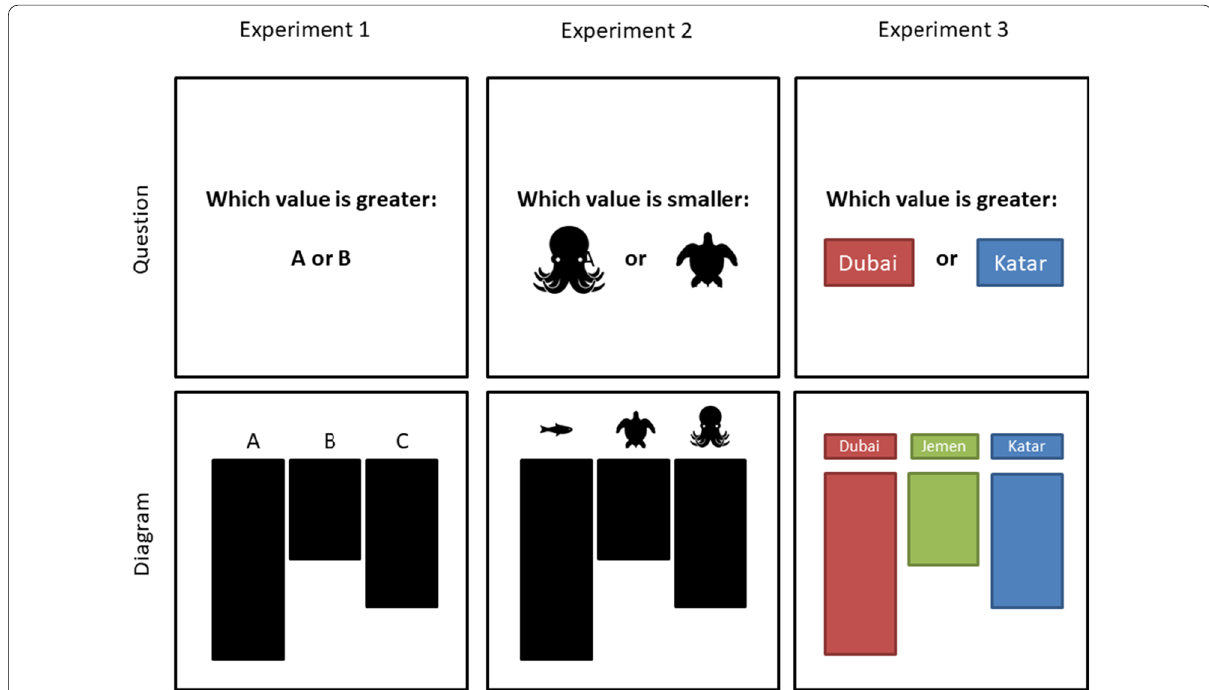
Fig. 3 Schematic depiction of the stimuli for the reported experiments. Experiment 1 used letter and word labels. Experiment 2 employed word and pictograph labels. In Experiment 3, the coloring of the bars was manipulated. All bars had either the same or different